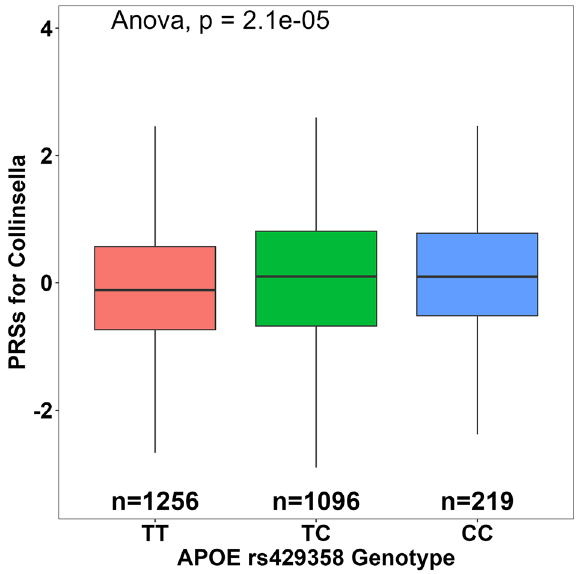
Figure 4. Genetic association between PRSs for Collinsella and APOE rs429358 genotype in the discovery sample. Individuals in the discovery sample were separated by their genotype at the APOE SNP rs429358. Those with the genotype of TC and CC had higher PRSs for genetically predicted Collinsella abundance than those with the TT genotype.